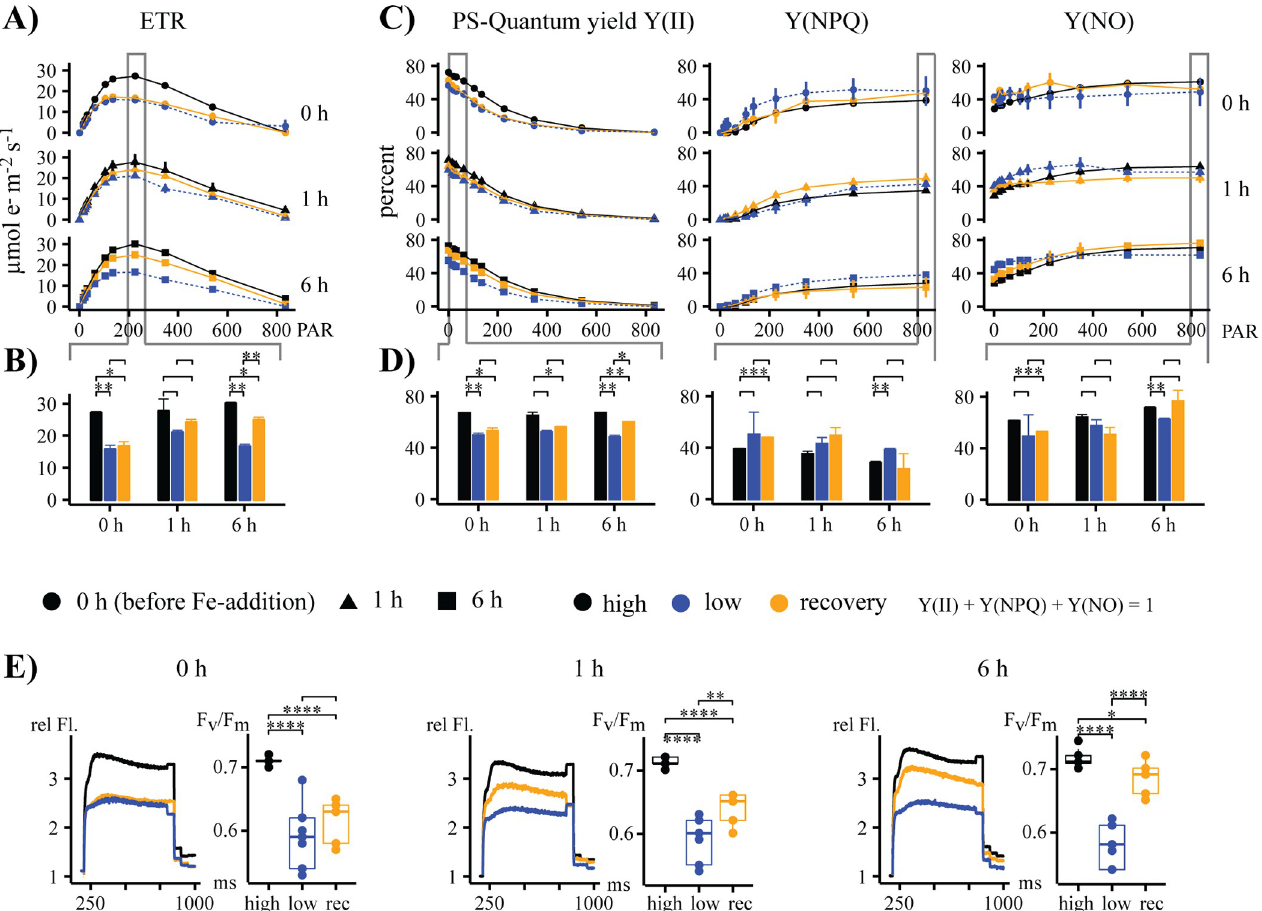
Fig 3. Changes in photo-physiological parameters throughout 6 h during the short-term (ST) experiment. High-iron, low-iron, and iron-recovery samples are shown in black, blue, and orange, respectively. The 0 h, 1 h, and 6 h sampling times are indicated as triangles, squares, and circles, respectively. (A) Electron transfer rate (ETR) in μ mol e m -2 s -1 . (B) Bar graphs of ETR max with Student’s t-test indicate statistically significant differences. (C) Photochemical quantum yield (PS-quantum yield Y(II)), non-photochemical quenching (Y(NPQ)), and non-regulated energy dissipation (Y(NO)). (D) Bar graphs of Y(II), Y(NPQ), and Y(NO) with Student’s t-test. (E) Light-induction curves and the corresponding F v /F m values with ‘Student’s t-test showing statistical differences. Statistically significant P values are indicated as � < 0.05, �� < 0.01, ��� < 0.001, ���� < 0.0001. A line without stars indicates a test that is not statistically